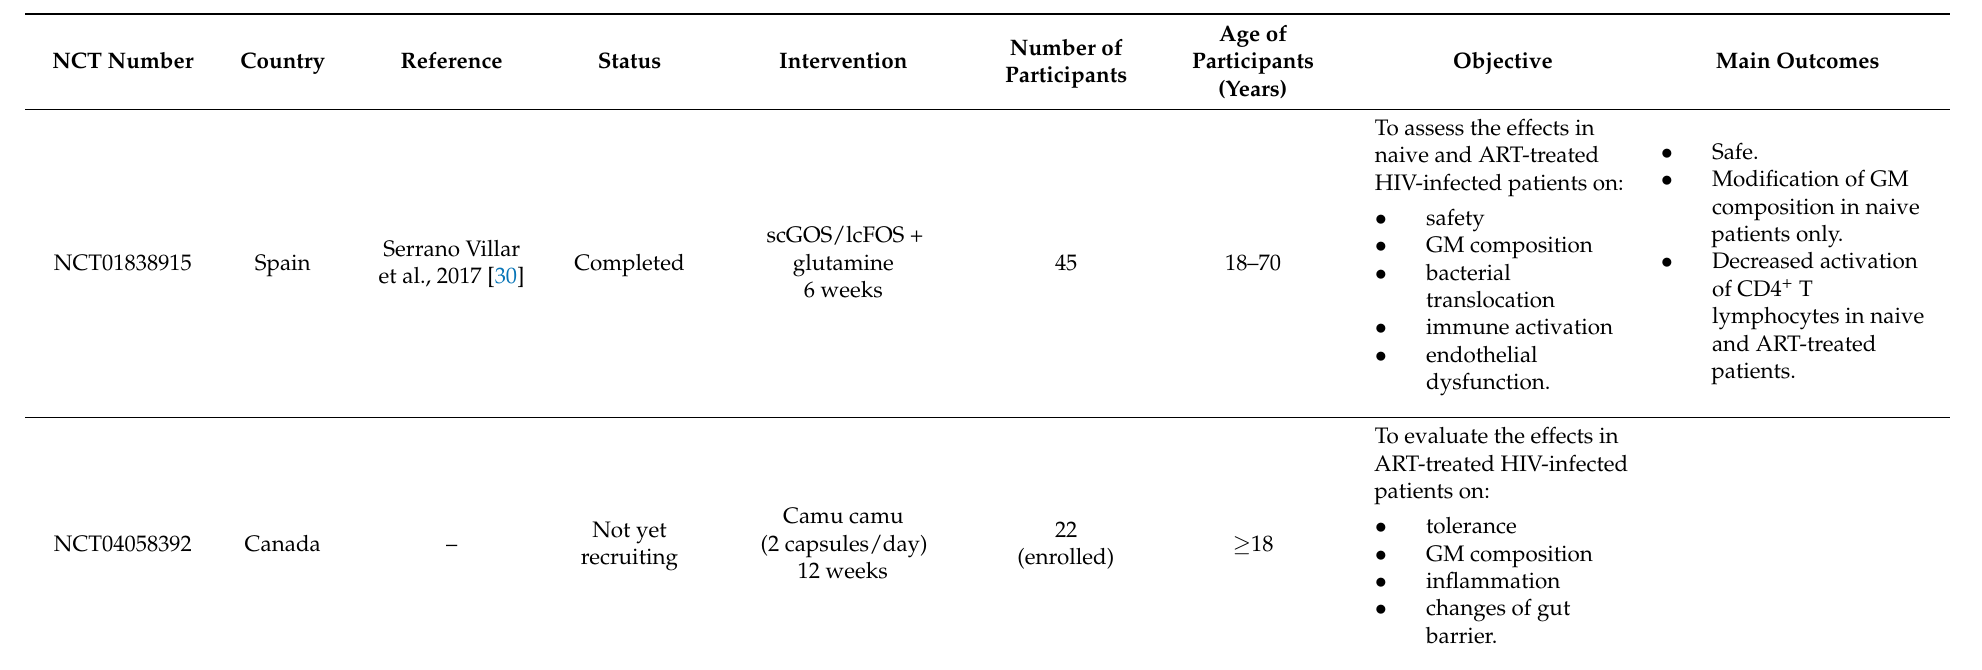
Table 1. Clinical trials concerning prebiotics registered in